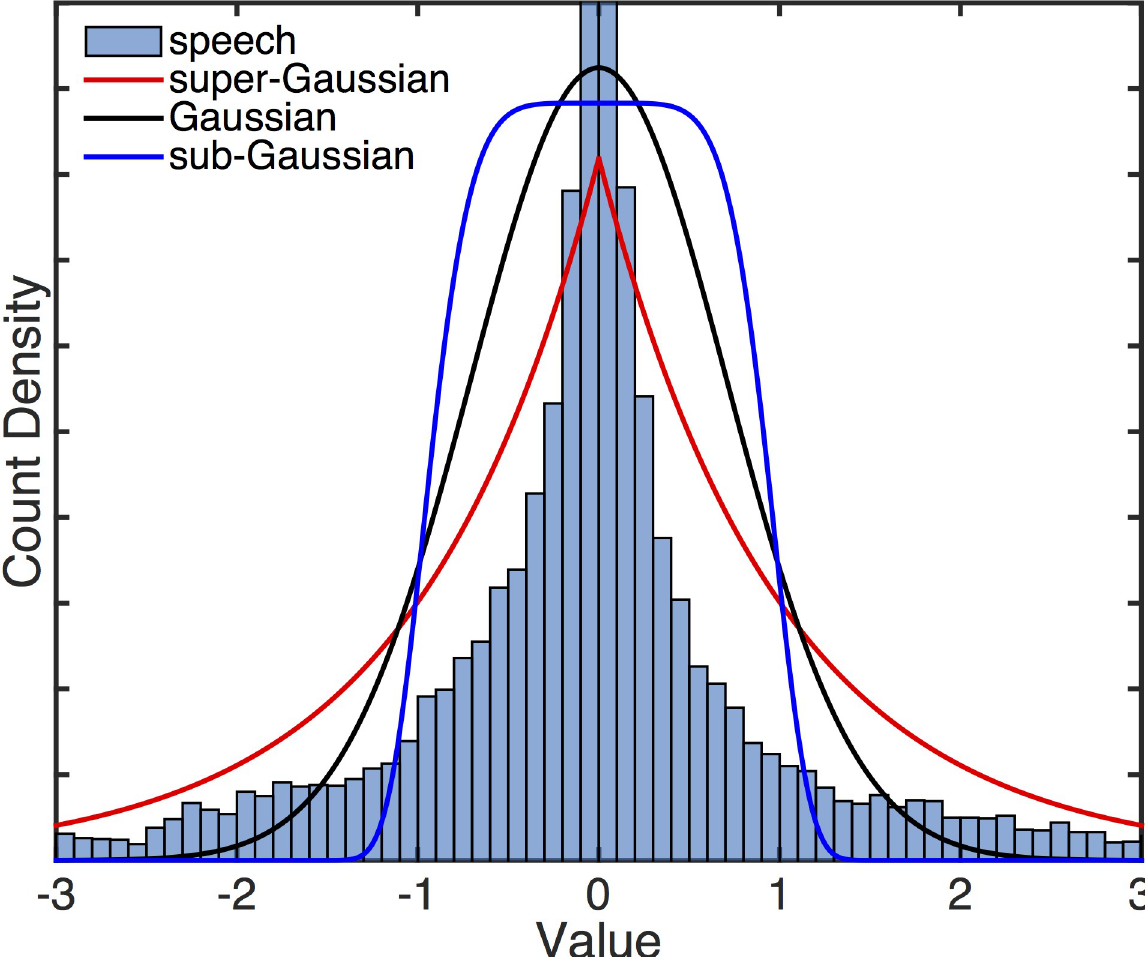
Fig 2. Examples of super- and subgaussian sources. Shownhere are histograms for a Gaussian source (black), a subgaussian source (the generalizedGaussian), and a supergaussian source (Laplace).Also shown is a histogramfor one of the speech signals used in this study. The speech signal is far more leptokurtic than the Laplacesource; without truncating the y -axis the massive spike near zero of the speech signal obscuresthe shapes of the other